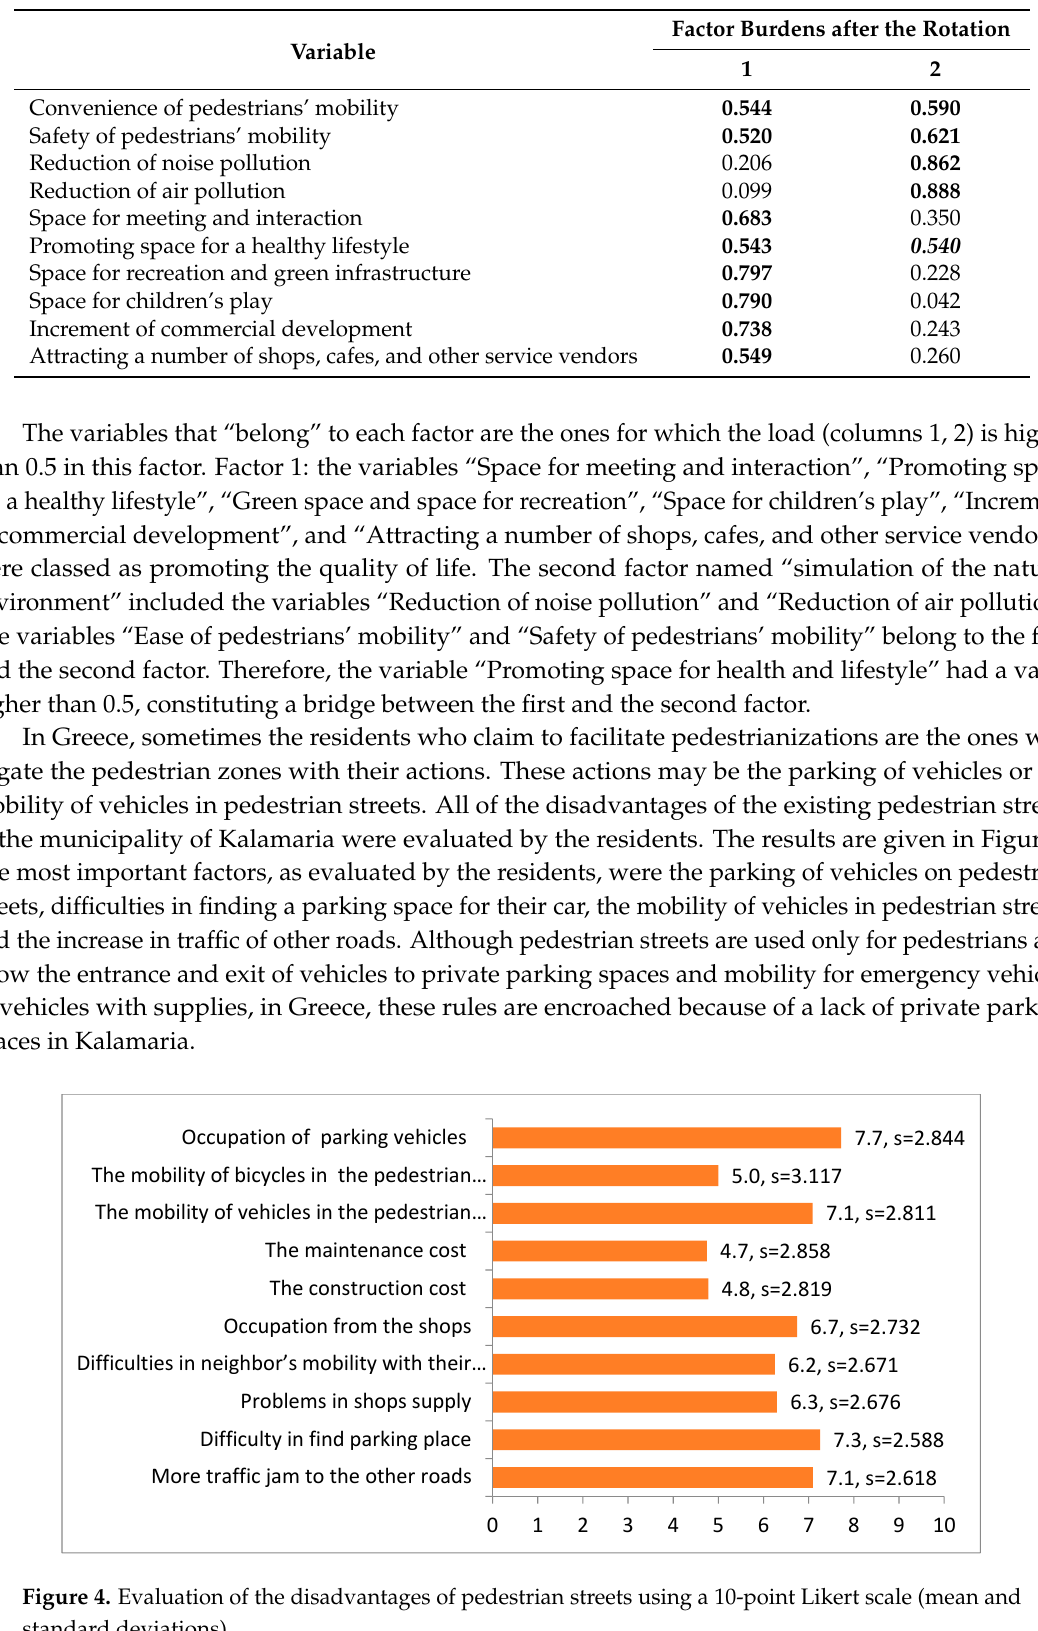
Table 2. Factor burdens after rotation for the multivariable advantages of pedestrian streets.